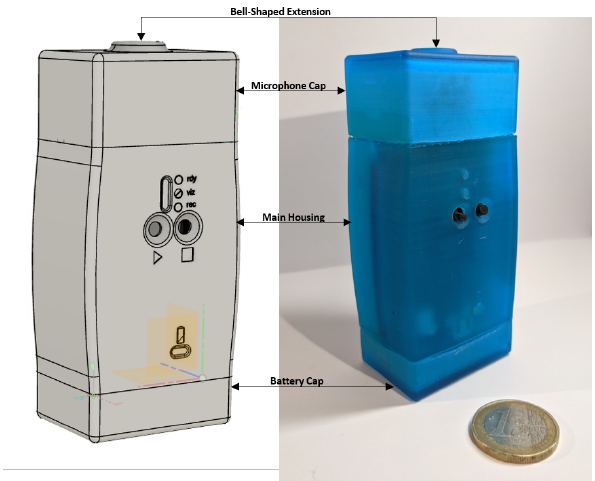
Figure 1. Mechanical 3D housing ( left ) and prototype ( right